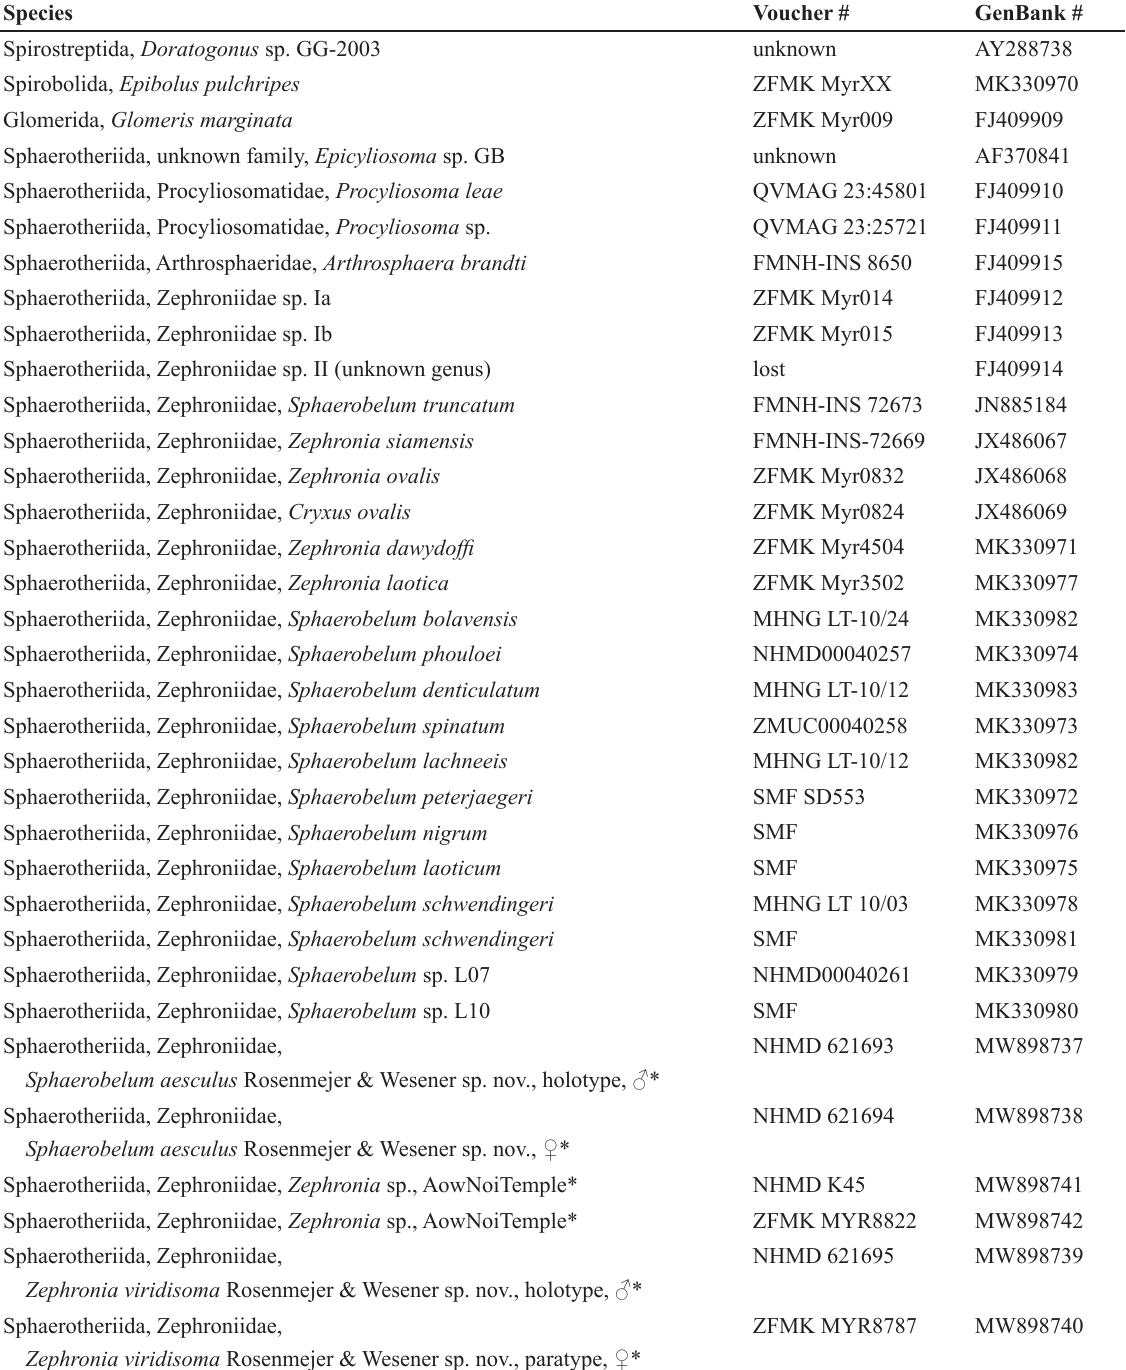
Table 2. Genetically analysed specimens, voucher and GenBank number. Specimens marked by an * have been newly sequenced. Abbreviations: MHNG = Muséum d’Histoire naturelle de la Ville de Genève, Geneva, Switzerland; NHMD = Natural History Museum of Denmark, University of